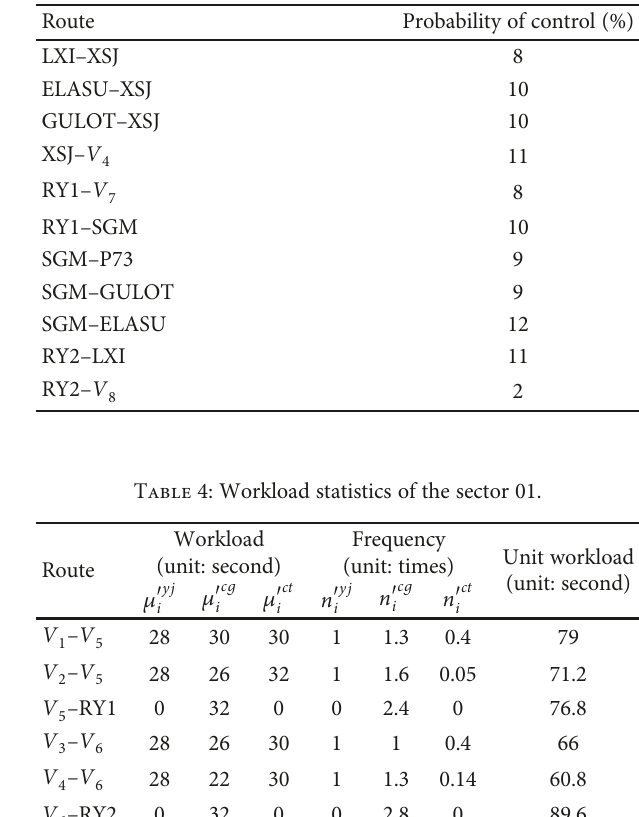
Table 1: Distribution of control preference for each route of the sector 01.